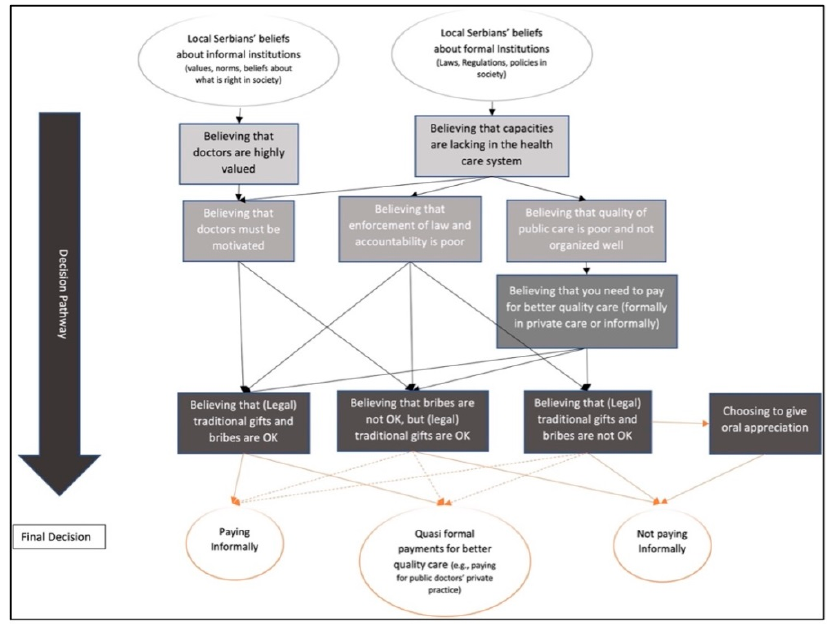
Figure 1. Illustration of potential pathways to informal patient payments perceived by civil servants.